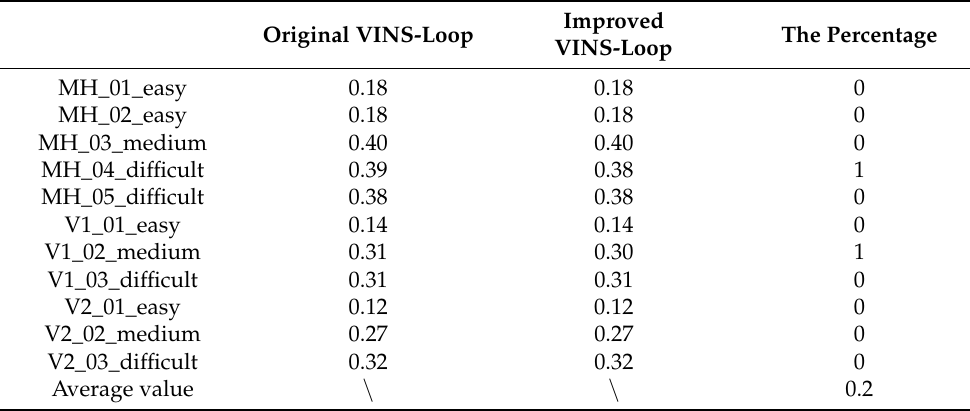
Table 12. Percentage of accuracy improvement between the original algorithm and the optimized algorithm with loopback (unit: